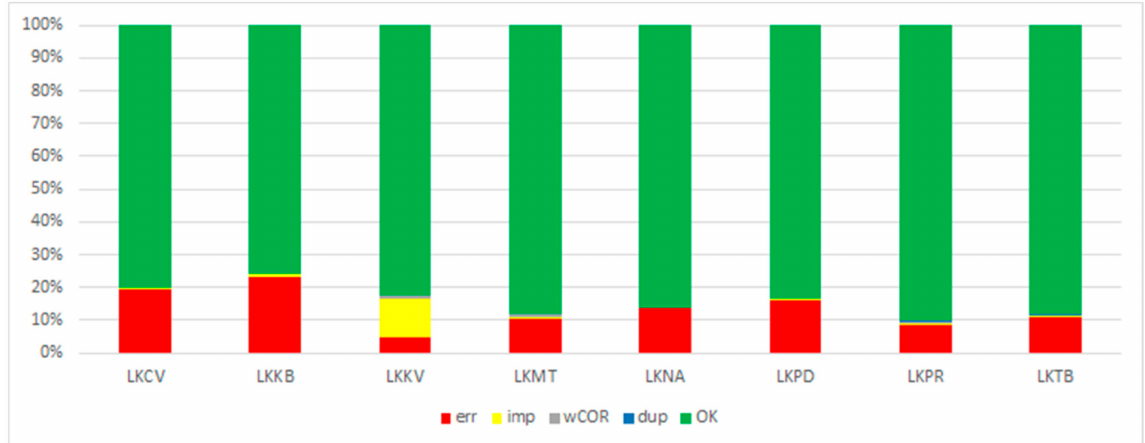
Figure 2. Results of the SPECI report evaluation; err: the portion of SPECI, where criteria for inclusion were not met; imp: the ratio of reports, where evaluation was not possible; wCOR: the rate of reports not assessed due to the upcoming corrective report COR; dup: the number of duplicated reports or identical reports; OK: the number of reports where criteria for the issue were met.